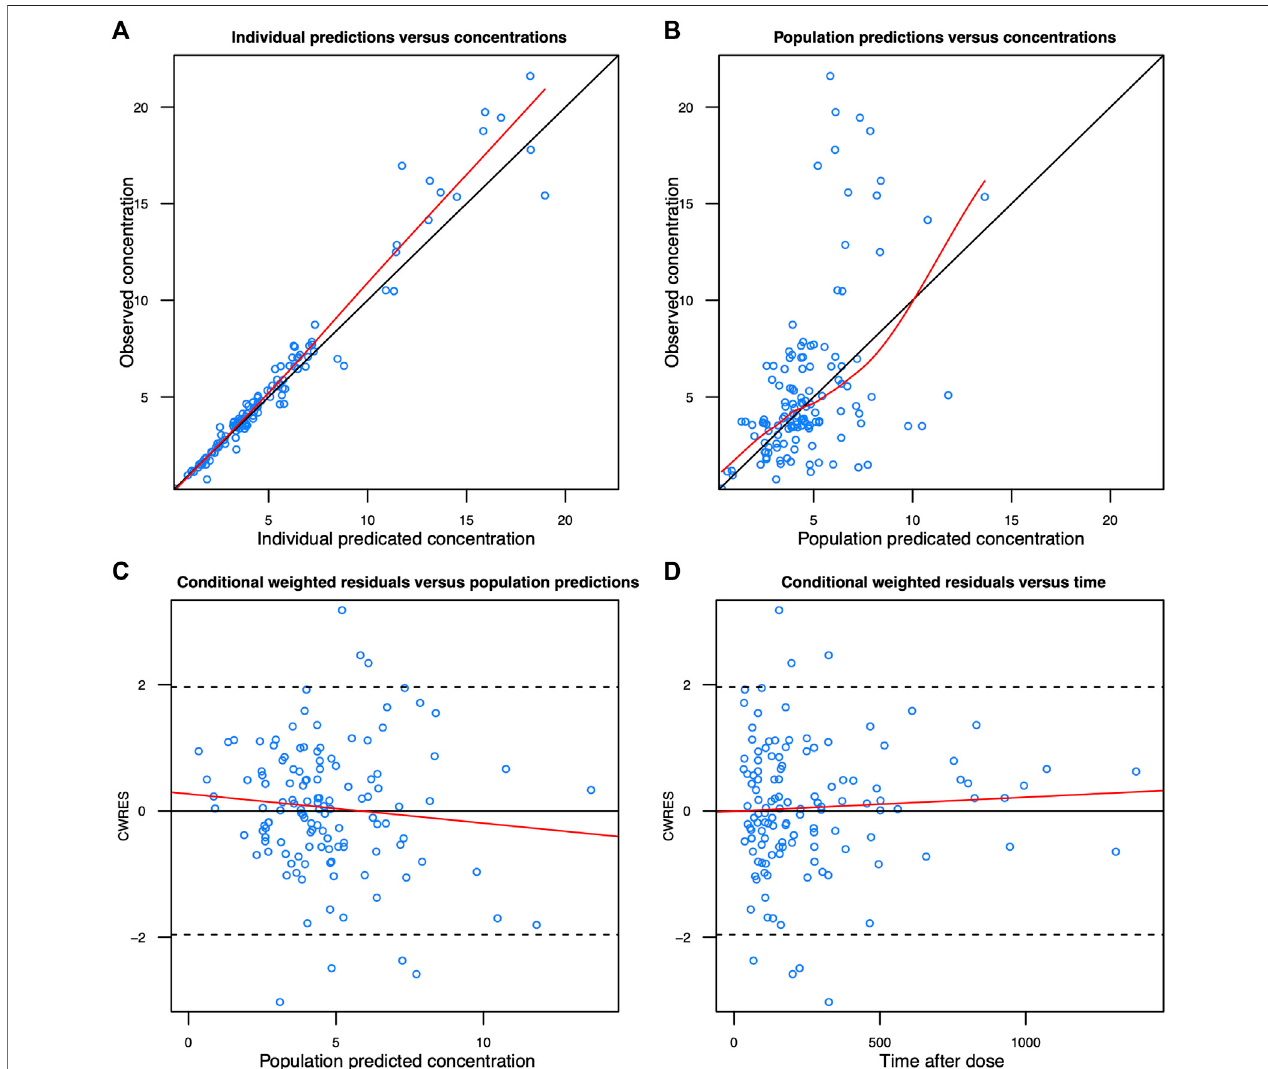
FIGURE 1 | Diagnostic goodness-of- fi t plots of the fi nal model. (A) Observed concentration (DV) vs. individual predicted concentration (IPRED); (B) DV vs. population-predicted concentration (PRED); (C) conditionalweighted residuals (CWRES) vs. PRED; and (D) CWRES vs. time. The red lines inthe upper panel represent loess smooth lines and linear fi t lines,